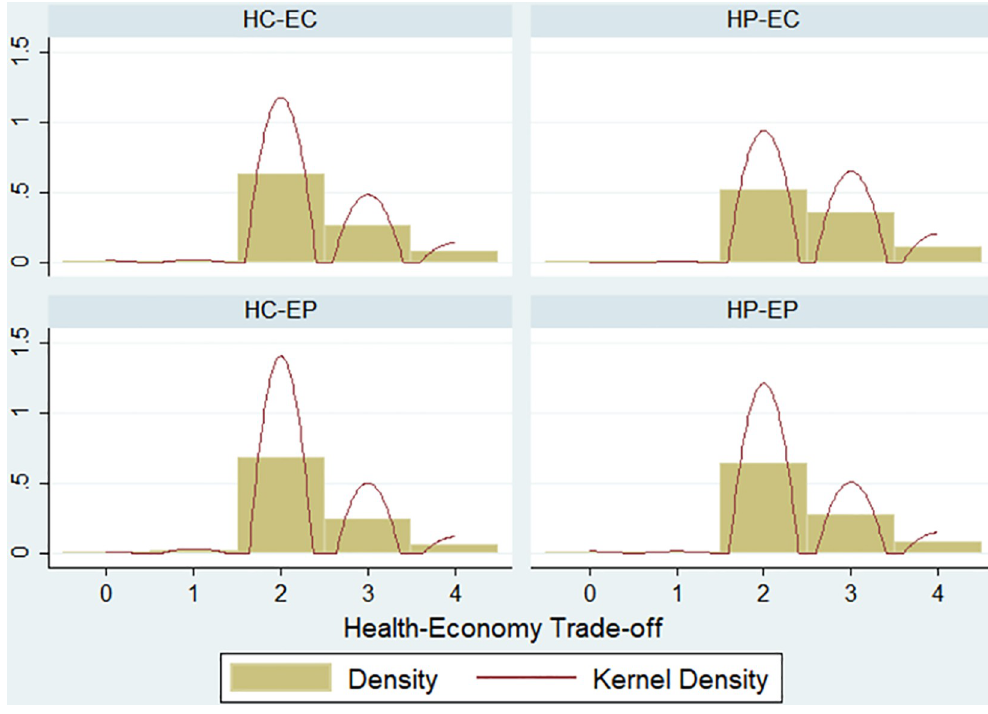
Fig 1. Distribution of responses by